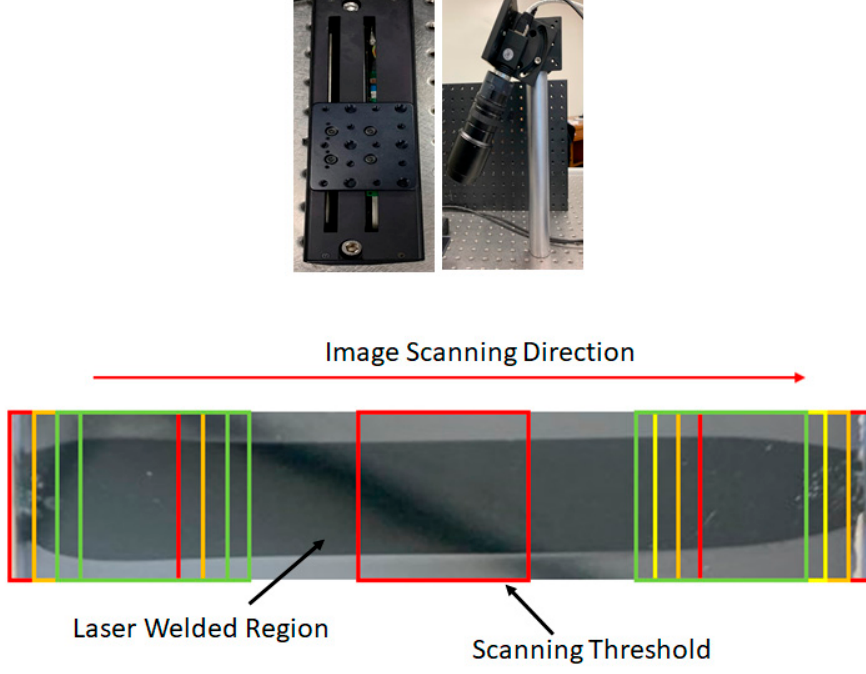
Figure 3. Progressive image acquisition process.